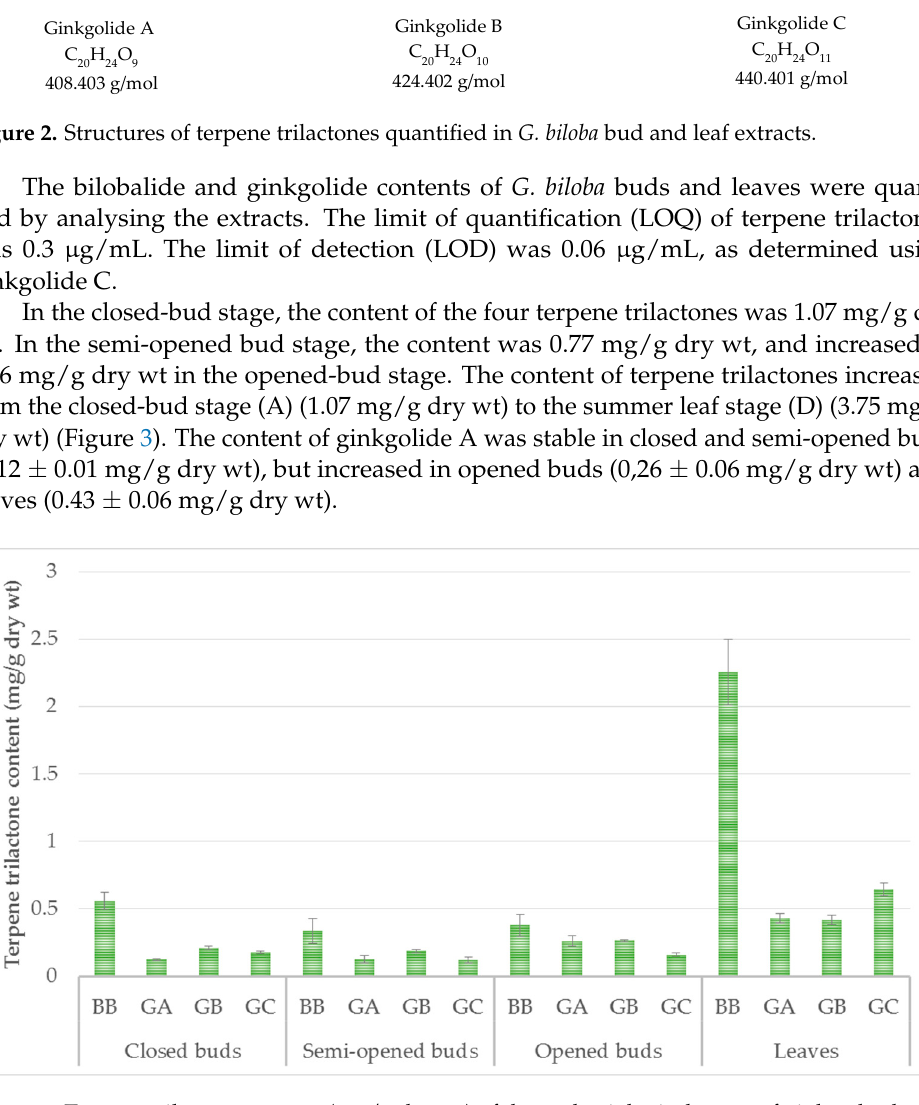
Figure 3. Terpene trilactone content (mg/g dry wt) of three physiological states of ginkgo buds and summer leaves. GA = Ginkgolide A, GB = Ginkgolide B, GC = Ginkgolide C, BB = bilobalibe. Data are given as mean ± SD, replicates are n = 3 and p < 0.001.